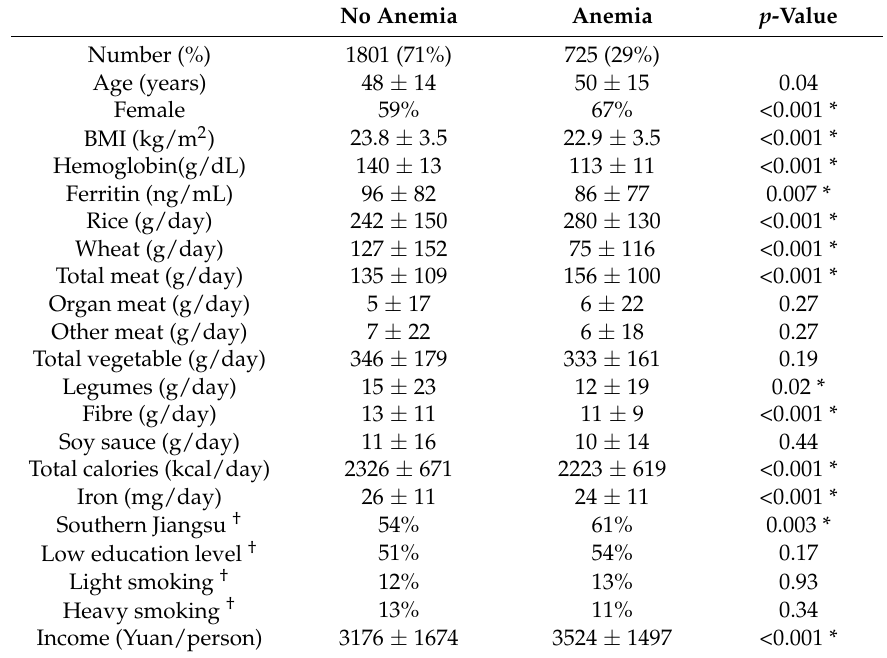
Table 2. Baseline associations (sex-stratified, age matched, and adjusted) with prevalent anemia (Figure 1B,D).